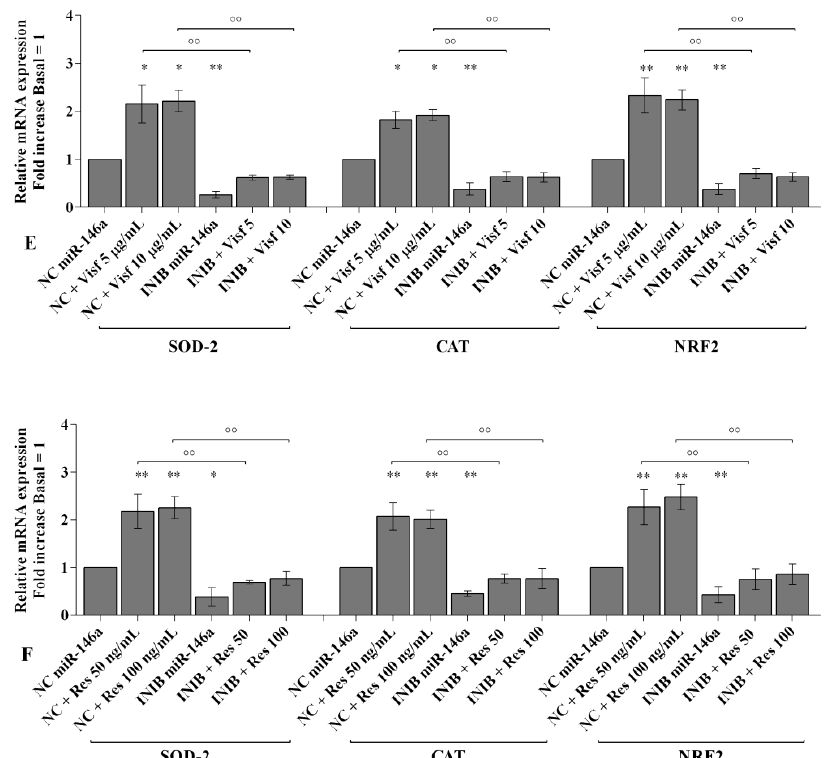
Figure 7. ( A , C , D ) Mitochondrial superoxide anion production was assessed by flow cytometry using MitoSox Red staining. ( B , E , F ) Expression levels of superoxide dismutase ( SOD-2 ), catalase ( CAT ), nuclear factor erythroid 2 like 2 ( NRF2 ) by real-time PCR. Human osteoarthritic (OA) synovial fibroblasts were evaluated at basal condition, after 24 h of transfection with miR-146a inhibitor or NC, and after incubation with visfatin (5 and 10 μg/mL) and resistin (50 and 100 ng/mL). The superoxide anion production and the gene expression were referenced to the ratio of the value of interest and the value of basal condition (basal, cells without treatment) or NC, reported equal to 1. Data were expressed as mean ± SD of triplicate values. * p < 0.05, ** p < 0.01 versus basal condition or NC. ° p < 0.05, °° p < 0.01 versus inhibitor. INIB= inhibitor, NC= negative control siRNA, Visf= visfatin, Res = resistin.